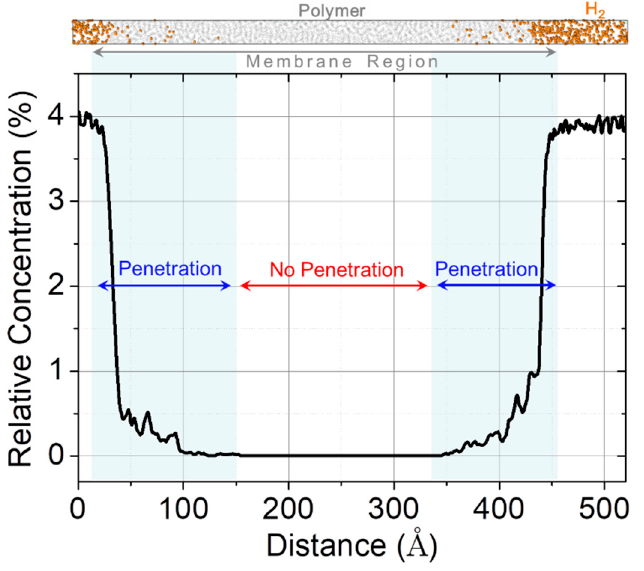
Figure 2. Relative concentration profile of hydrogen molecules. The simulation system is divided into penetrated and not penetrated regions. Their ratio is considered as a criterion for the comparison of penetration as a result of the side chain morphology.